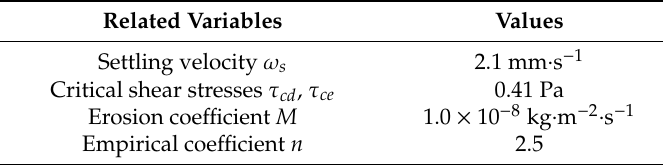
Table 2. Model parameters used for cohesive sediment calculation.